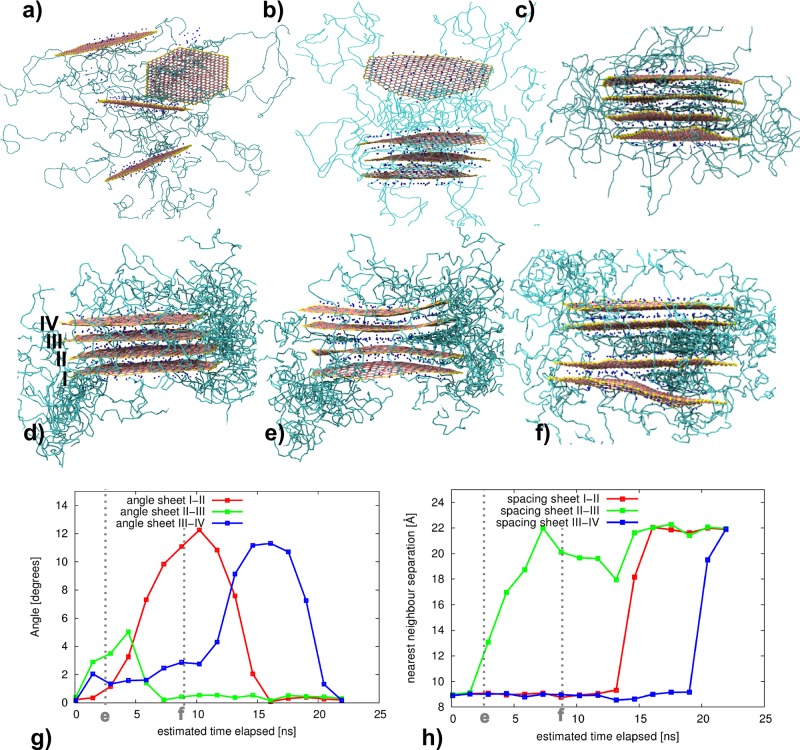
Overview of two intercalation processes for selected tactoids, one in the “long” PEG system (a–c) and one in the “long” PVA system (d–f). The polymer molecules are represented by the green bonds; for the clay CG particles the colors are: neutral clay is pink, charged clay is cyan, edge clay is yellow, and sodium is blue. Only selected polymer molecules are shown to aid visualization. In the “long” PEG system, which starts as a single tactoid in an exfoliated state (a), the clay sheets gradually self-assemble into an intercalated clay tactoid (see (b) for an intermediate snapshot and (c) for the final state). A monolayer of PEG remains between the MMT sheets, resulting in a clay tactoid with an average d-spacing of about 16 Å. In the “long” PVA simulation the clay sheets, initially unmixed (d) begin to undulate, which initially leads to an opening in the center of the tactoid and the entrance of PVA molecules between the central sheets (e). As time progresses, the outer sheets further undulate and, through the formation of a solitary wave that propagates along the clay platelet, intercalation occurs in the remainder of the tactoid as well (f). g) We present the nearest-neighbor distance between each adjacent pair of sheets in the tactoid shown in Figure 2d–f as a function of the simulated time in nanoseconds. h) We present the angle between the planes that are fitted to each of the clay sheets. This angle allows us to determine whether adjacent clay sheets are fully parallel (angle = 0°) or whether the tactoid has opened up, with a pair of clay sheets having a greater separation distance on one side than on the other. We observe that increases in d-spacing are preceded by changes in the angle between adjacent clay sheets, and conclude that sheet bending triggers these intercalation events.